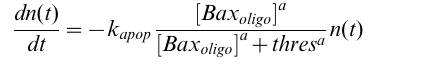
tBid release from complexes with Bcl2 by